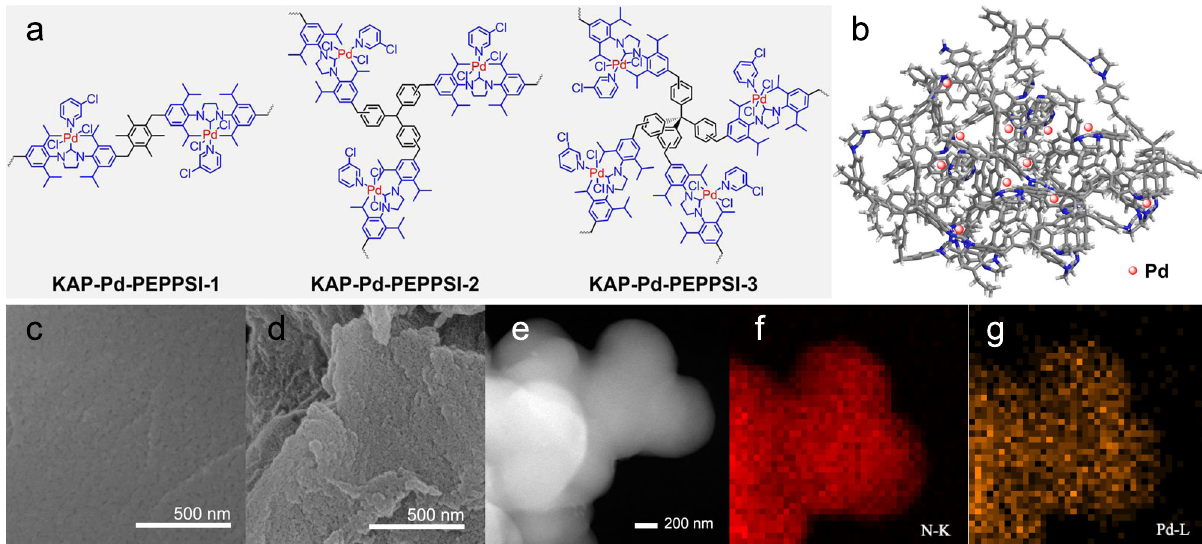
Fig. 2 Structure and characteristics of KAP-Pd-PEPPSI. a Structures of KAP-Pd-PEPPSI with different degrees of crosslinking. b Simulation model for hypercrosslinked KAP-Pd-PEPPSI-x (x = 2, 3). c SEM image of KAP-Pd-PEPPSI-2. d SEM image of KAP-Pd-PEPPSI-2 after swelling in DMF for 24 h